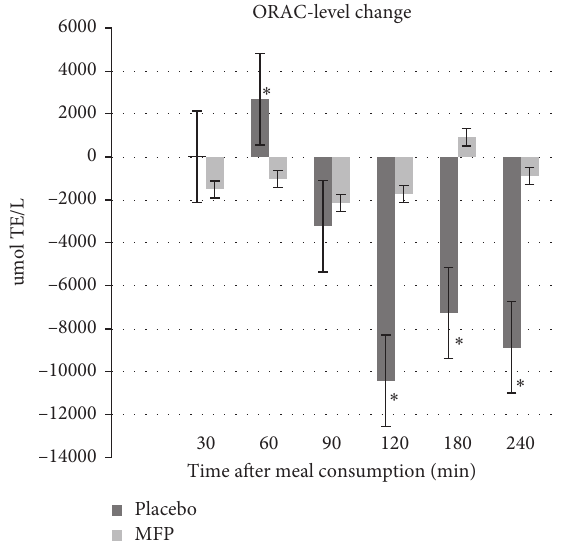
Figure 4: Postprandial blood ORAC level change from the be- ginning (min 0) in MFP jelly and control groups, data expressed as mean ± SE. ∗ Statistically significant with p value < 0.05.